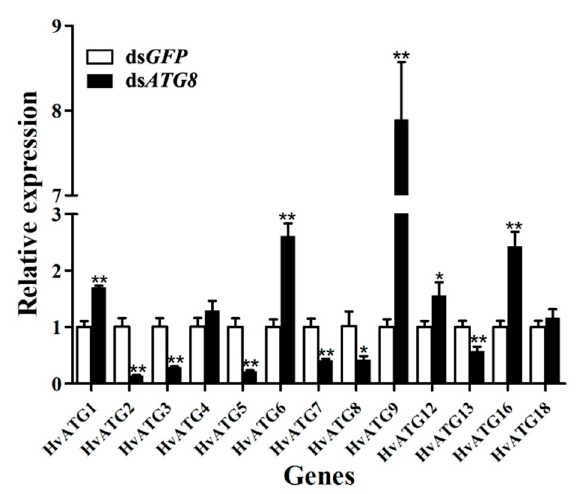
Figure 5. Expression levels of 13 HvATGs at 72 h after HvATG8 silencing (n = 50 larvae in each biological replicate). Error bars represent mean ± standard error of three biological replicates. * p < 0.05, ** p < 0.01, via two-way analysis of variance followed by Students’ t